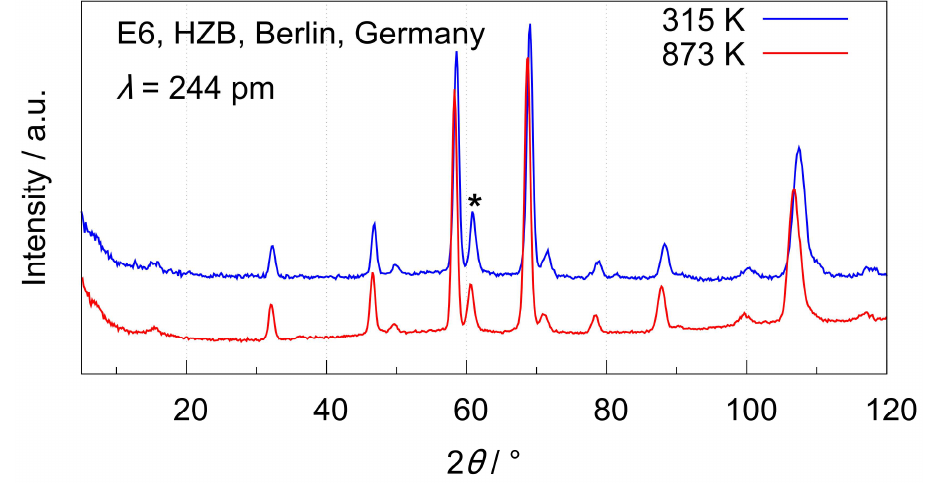
Figure 3. Powder neutron diffraction data of Ba 2 In 1.8 Cr 0.2 O 5.3 (H 2 O) x at 315(1) K and 873(2) K with 2 h data collection time each and without offset, contribution of the Nb-heating element of the furnace marked with *, E692925 and E692936–E692937. The furnace was operated in dynamic vacuum ( p min ≥ 1 × 10 − 3